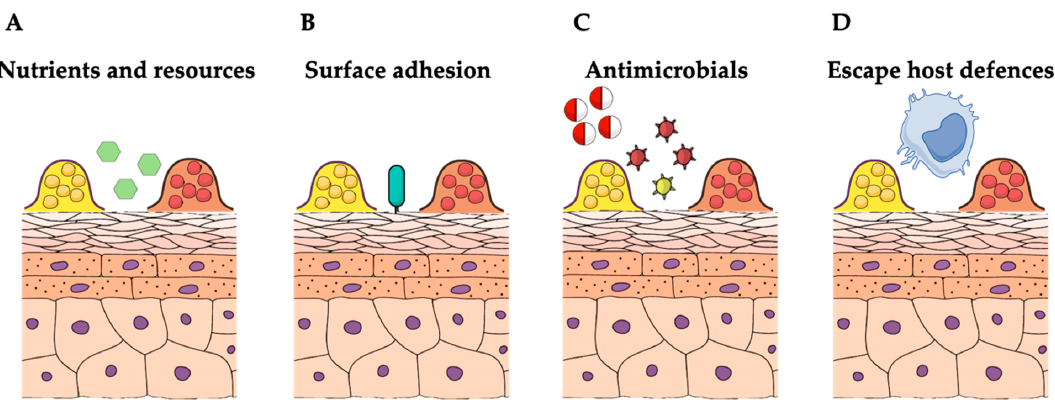
Figure 2. Competition dynamics among biofilm-growing staphylococci in the skin. ( A ) Staphylococci compete for the acquisition of the limited nutrients on the skin surface. ( B ) CoNS and S. aureus compete for surfaces attachment and persistent colonization. ( C ) Antibiotics and bacteriocins can limit staphylococci biofilm colonization. ( D ) S. aureus can contribute to the chronic inflammation in atopic dermatitis while escaping the immune system. The image is adapted from Mind the Graph (https: // mindthegraph.com) under a Creative Commons